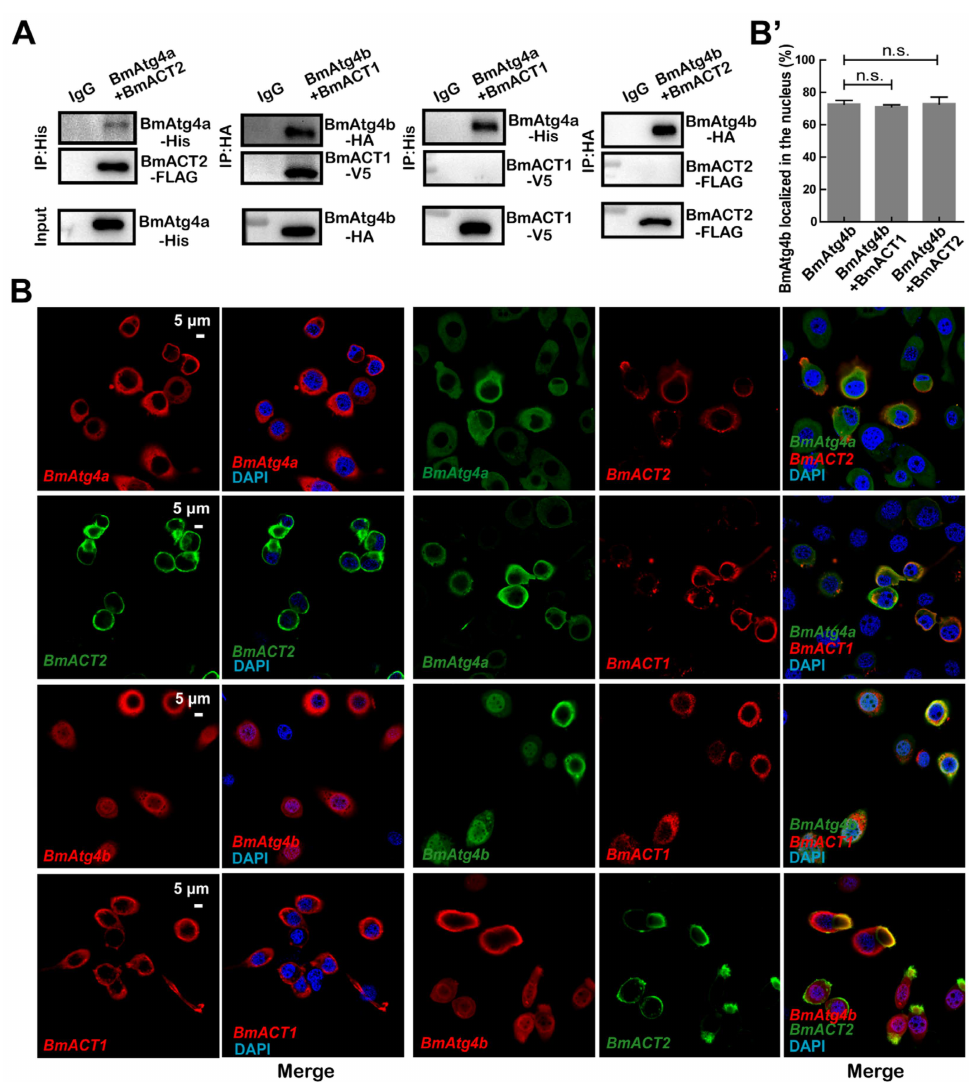
Figure 6. Interaction between BmAtg4a/BmAtg4b and BmACT2/BmACT1 indicated by Co-IP and IF staining in BmN cells. ( A ) Co-IP assays of BmAtg4a and BmACT2, BmAtg4b and BmACT1, BmAtg4a and BmACT1, as well as BmAtg4b and BmACT2. ( B ) IF staining of the co-overexpressed BmAtg4a and BmACT2, BmAtg4b and BmACT1, BmAtg4a and BmACT1 as well as BmAtg4b and BmACT2. ( B’ ) Quantification of nuclear BmAtg4b in ( B ) indicated by the percentage of cells